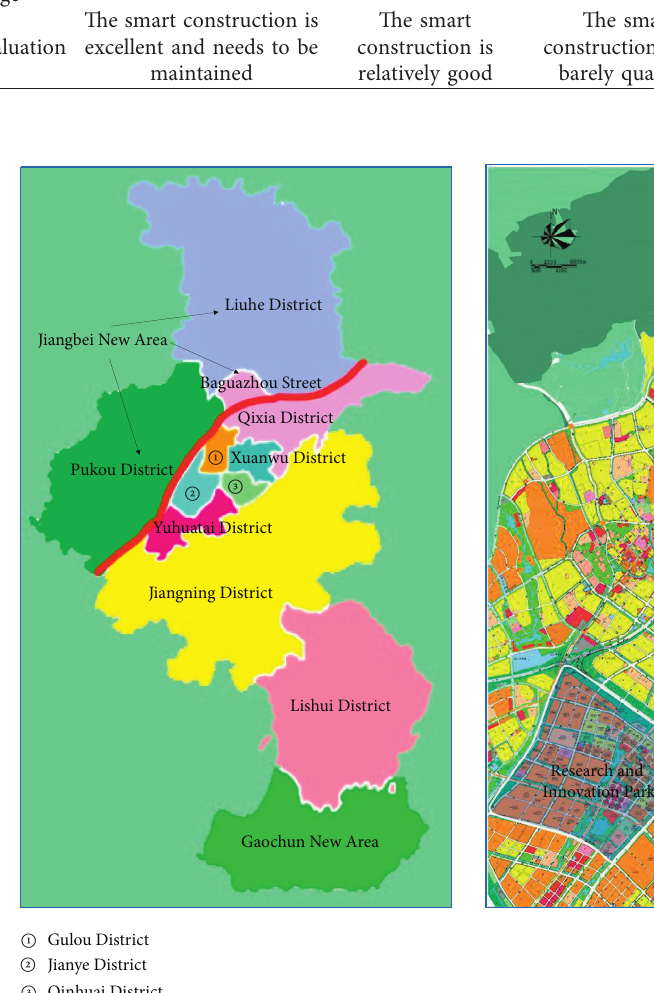
Figure 2: Location map of Jiangbei New District, Nanjing,